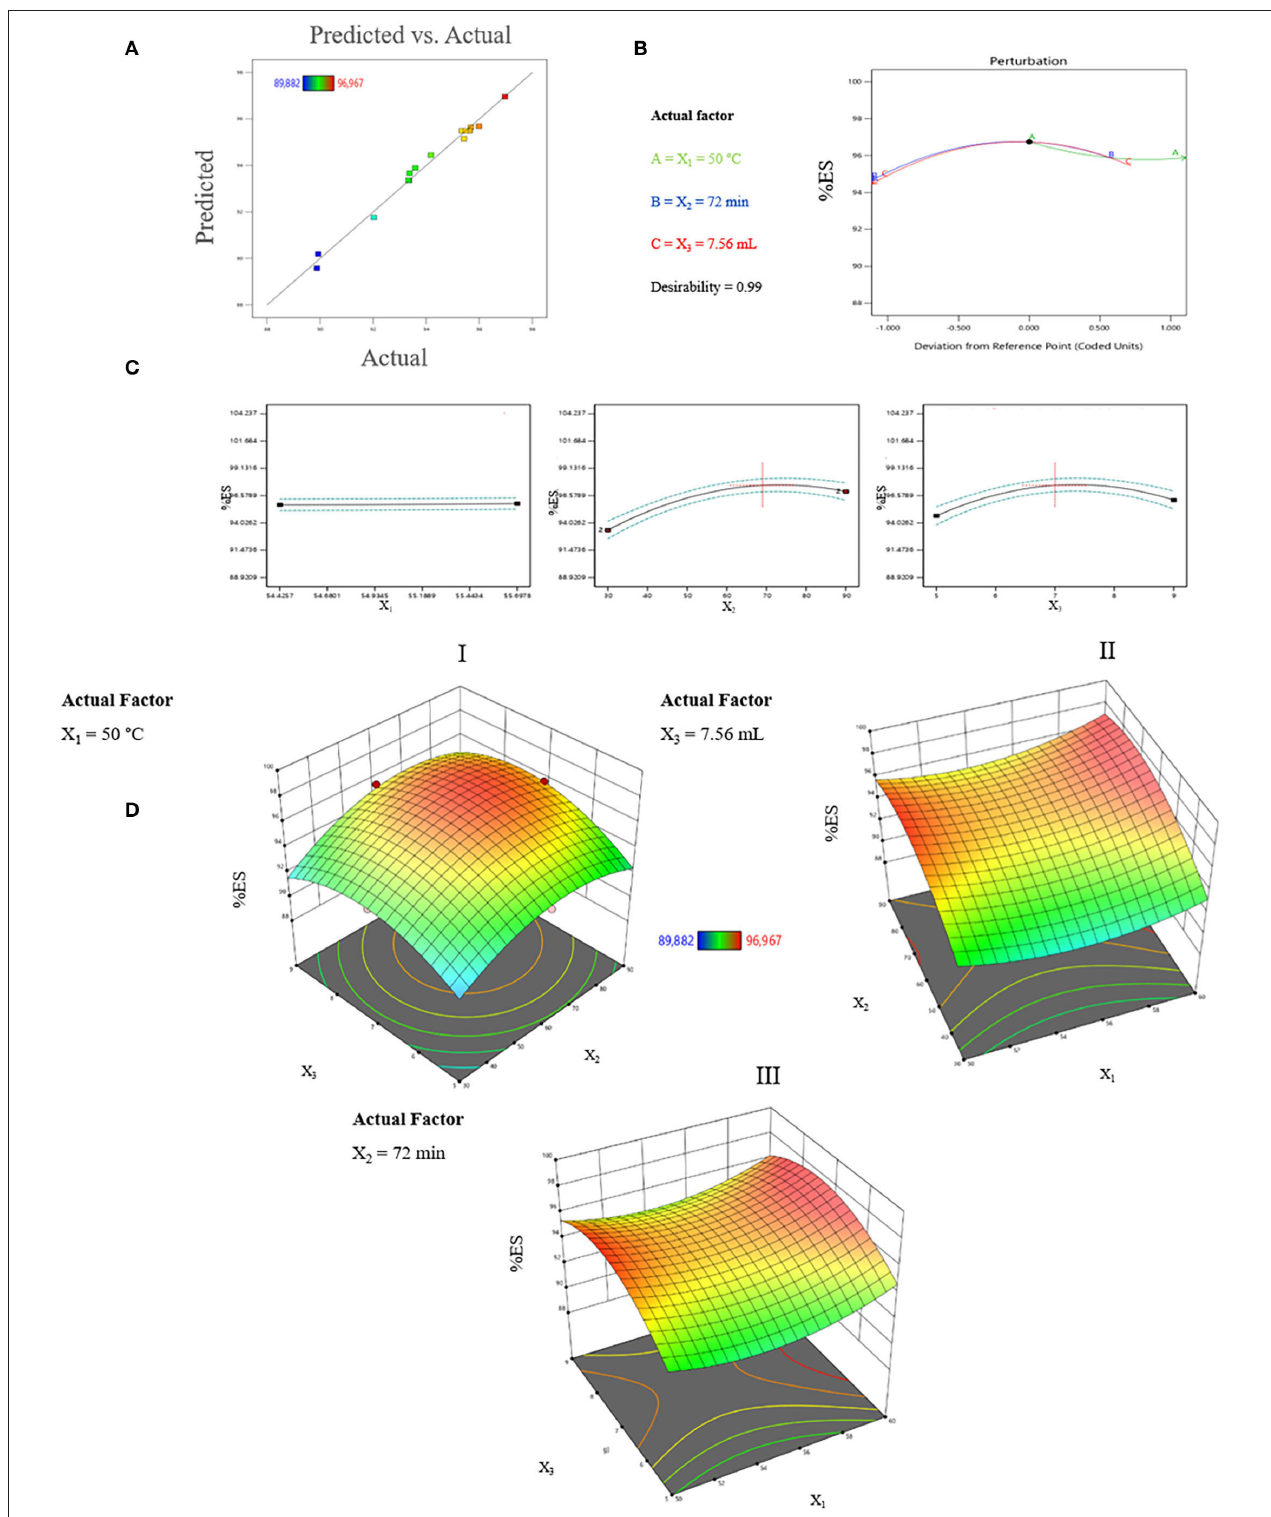
FIGURE 2 | (A) Graphical representation of the observed values as a function of predicted values (%). (B) Perturbation of optimal conditions. (C) Forecast profile of optimal conditions for %ES. X 1 = water temperature; X 2 = treatment time; and X 3 = quantity of water. (D) Response surface plots of the interaction effect between parameters on %ES during processing; DI, The effect of the interaction between treatment time and volume of water; DII, The effect of the interaction between water temperature and treatment time; DIII, the effect of the interaction between water temperature and volume of water.